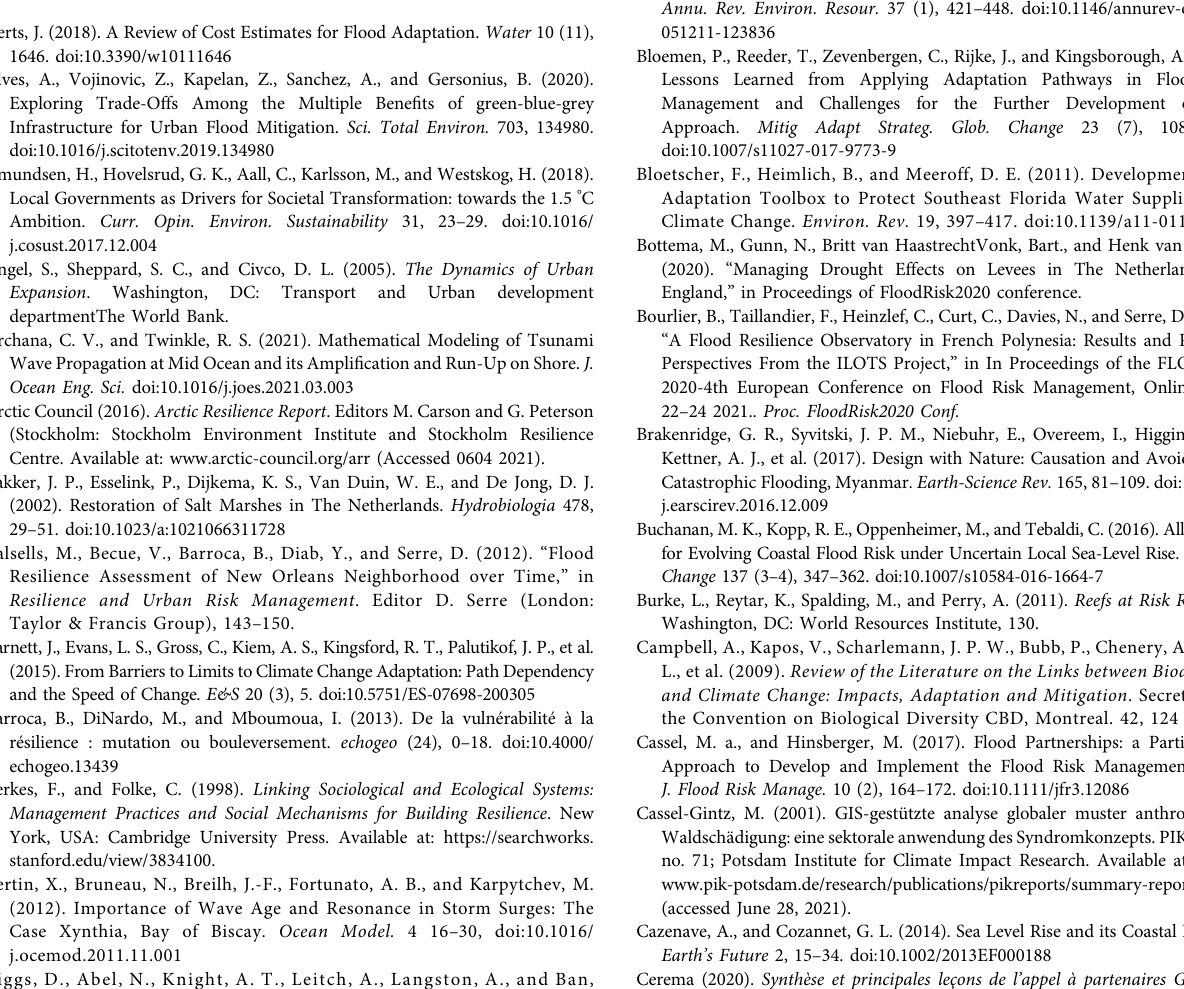
Supplementary Figure S7 | A comparison of analytical thinking and systemic thinking (Moberg and Galaz, 2005). Illustration by Henrik Ernstson. Supplementary FigureS8 | Overview of the main cascading effects of sea level rise. From Oppenheimer, M., B. C. Glavovic, J. Hinkel, R. van de Wal, A. K. Magnan, A. Abd-Elgawad, R. Cai, M. Cifuentes-Jara, R. M. DeConto, T. Ghosh, J. Hay, F. Isla, B. Marzeion, B. Meyssignac, and Z. Sebesvari. In: IPCC, 2019: Sea Level Rise and Implications for Low-Lying Islands, Coasts and Communities, Figure 4.13. Supplementary Figure S9 | Different types of responses to coastalrisks and sea level rise. From Oppenheimer, M., B. C. Glavovic, J. Hinkel, R. van de Wal, A.K. Magnan, A. Abd-Elgawad, R. Cai, M. Cifuentes-Jara, R.M. DeConto, T. Ghosh, J. Hay, F. Isla, B. Marzeion, B. Meyssignac, and Z. Sebesvari. In: IPCC, 2019: Sea Level Rise and Implications for Low-Lying Islands, Coasts and Communities, Box 4.3, Figure 1 . Supplementary Figure S10 | Overview of the main mitigation and adaptation measures (from Abram, N., J.-P. Gattuso, A. Prakash, L. Cheng, M.P. Chidichimo, S. Crate, H. Enomoto, M. Garschagen, N. Gruber, S. Harper, E. Holland, R.M. Kudela, J. Rice, K. Steffen, and K. von Schuckmann. In: IPCC, 2019, Framing and Context of the Report, Figure